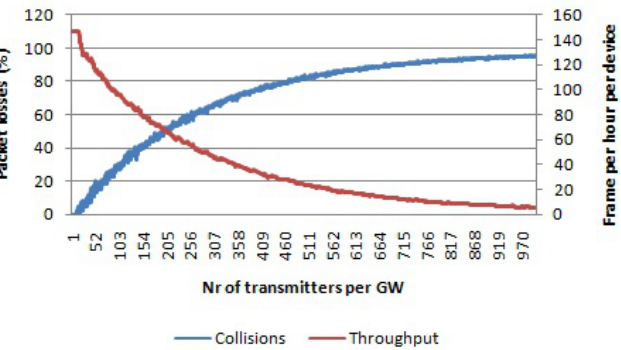
Figure 12. Percentage of packets lost due to collisions per number of transmitters per gateway using pure Aloha access. Average throughput per device. Payload size 20 bytes, single channel, multiple